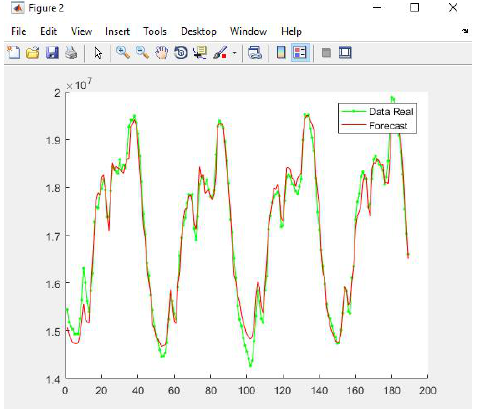
Fig. 14 Test result with traditional feed forward ANN for Wednesday Fig. 15 Test result with traditional feed forward ANN for Thursday